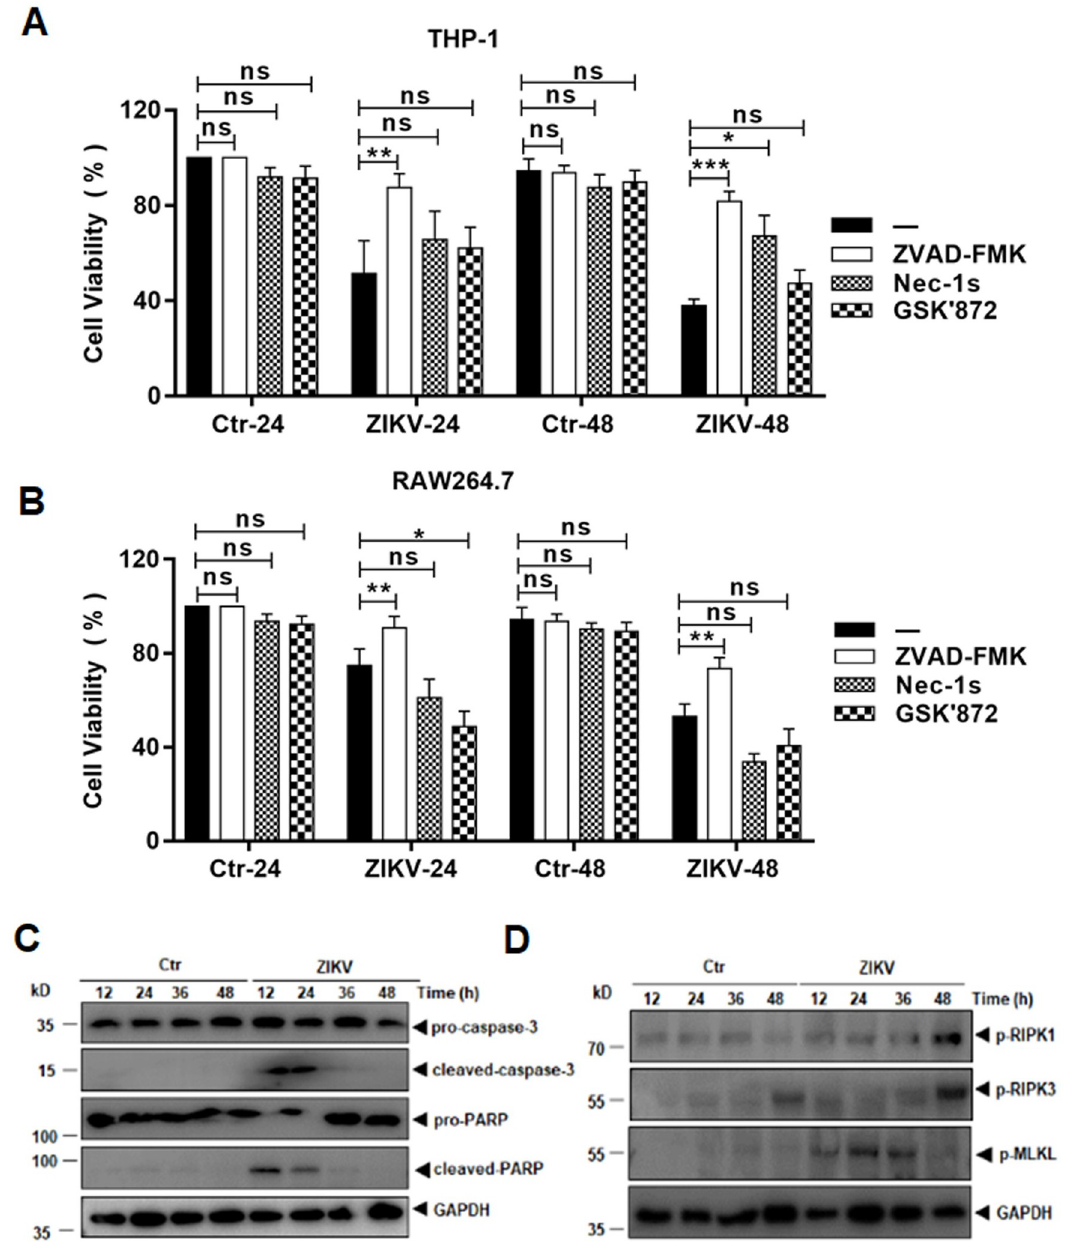
Fig 3. Blockage of cell death induced in ZIKV-infected cells by the inhibitors of programmed cell death. THP-1 ( A ) and RAW264.7 ( B ) cells were pre-treated with pan-caspases inhibitor, ZVAD-FMK, or RIPK inhibitors, Nec-1s and GSK’872, followed by infection with ZIKV at 1 MOI. The cell viability was assessed at 24 and 48 hrs p.i. with an MTT assay. The data were shown as mean ± SD and analysed by unpaired Students t-test. � , P < 0.05; �� , P < 0.01; ��� , P < 0.001. ns, no significance. ( C ) Cleavage of pro-caspase-3 and PARP in ZIKV-infected THP-1 cells as detected in a western blot analysis. ( D ) Phosphorylation of RIPK and MLKL in ZIKV- infected THP-1